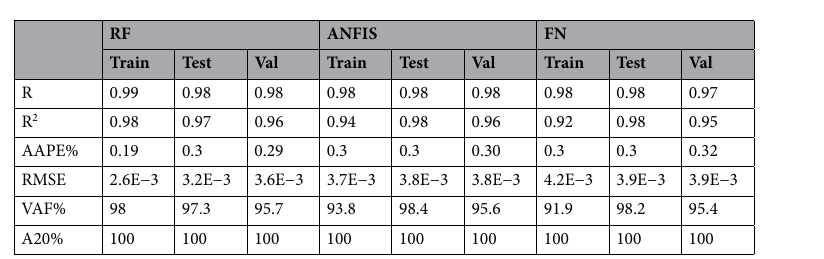
Table 5. Performance indicators summary for the training, testing, and validation datasets from the RF, ANFIS, and FN models to predict σ H from